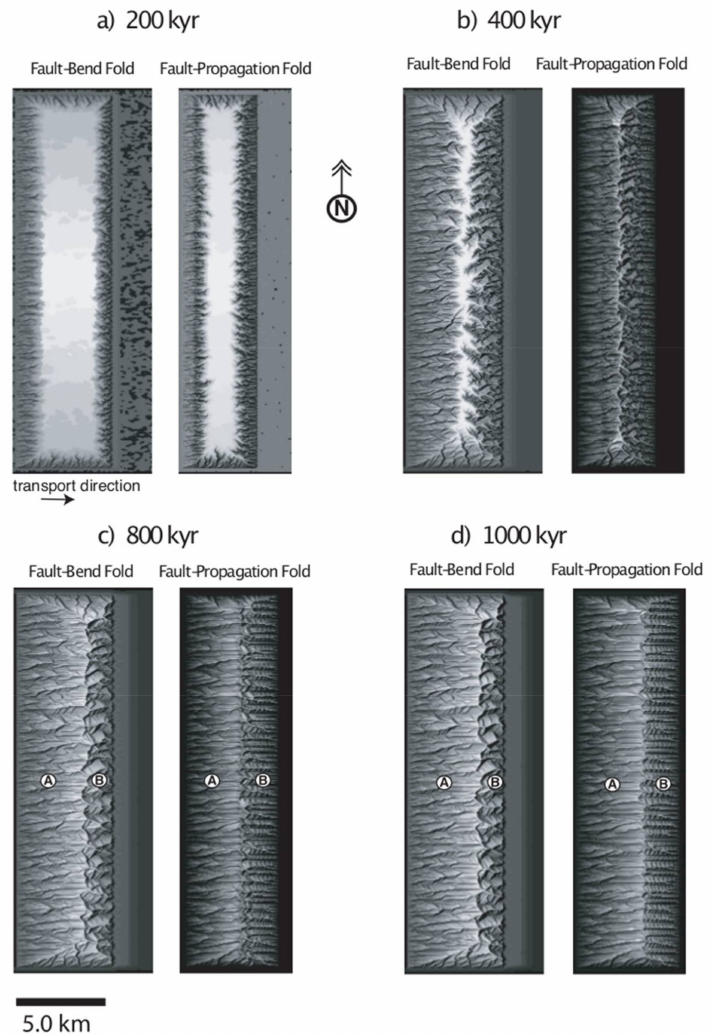
Figure 9. Evolution of the fault-propagation and fault-bend fold models under conditions of instantaneous lateral propagation and constant slip distribution, ( a ) 200 kyr, ( b ) 400 kyr, ( c ) 800 kyr and ( d ) 1000 kyr. Greyscale shaded relief images with illumination from NW, azimuth is 30 degrees. A and B are drainage basins discussed in